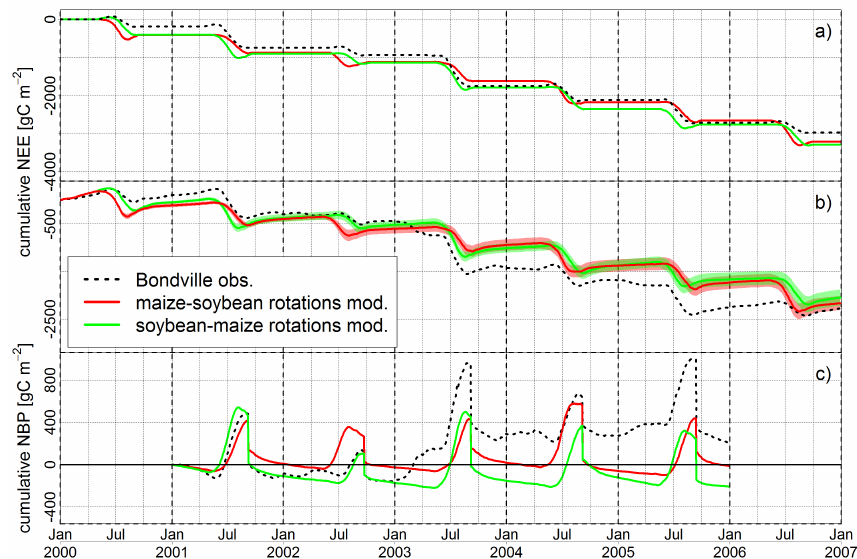
Fig. 6. Study area model averages (experiment DAmod) and Bondville EC data of (a) cumulative NEE for growing periods only, (b) cumulative NEE ( ± 1 σ study area model variability, shown as shaded areas), (c) cumulative NBP. Maize–soybean rotations: maize sown in even years, and vice versa for soybean–maize rotations.